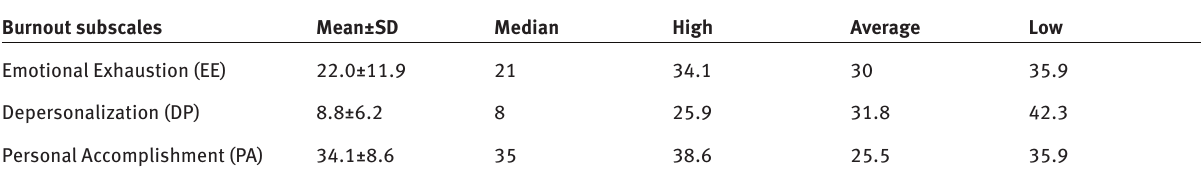
Table 3: Burnout subscales scores and normative categories (%). Burnout subscales